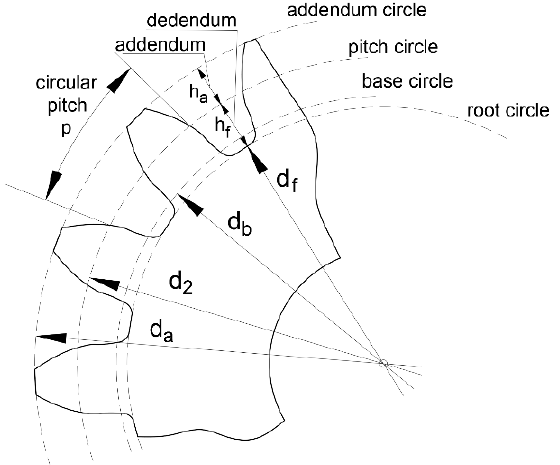
Figure 1. An involute gear and geometrical parameters. 𝑐 = 0.1 ÷ 0.25